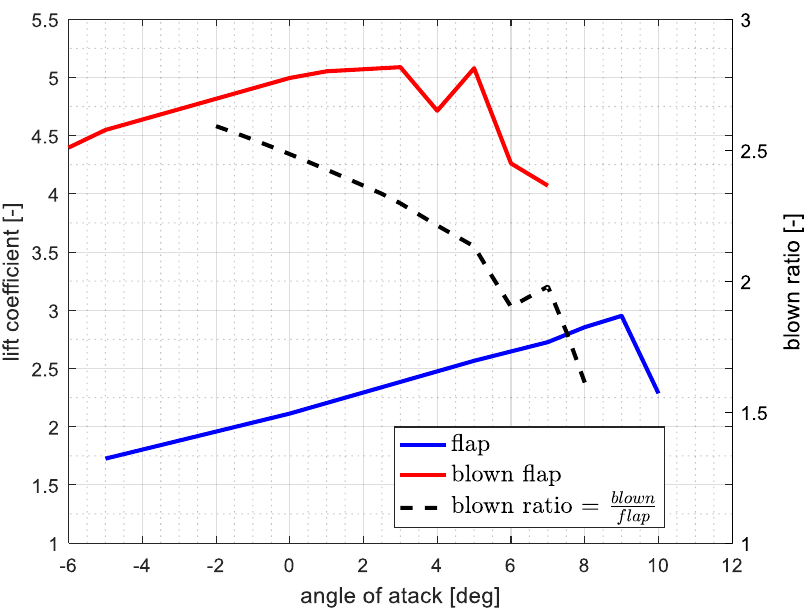
Figure 3. Lift coefficient as a function of the angle of attack for both the flap and blown flap configurations; the ratio between the pure flap and the blown flap.